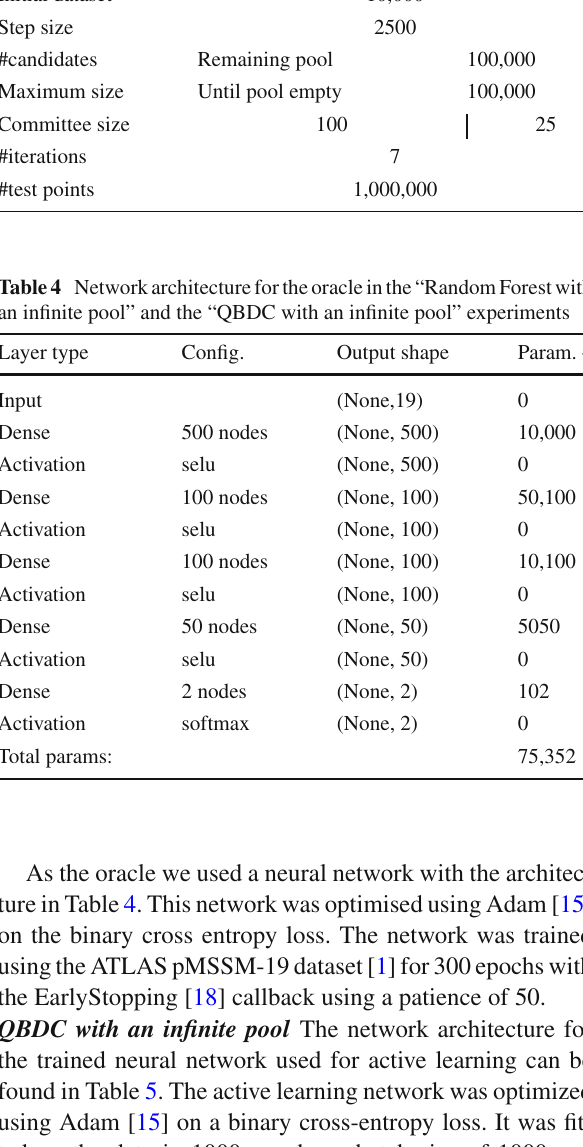
Table 5 Network architecture for the “QBDC with an infinite pool” experiment Layer type Config.